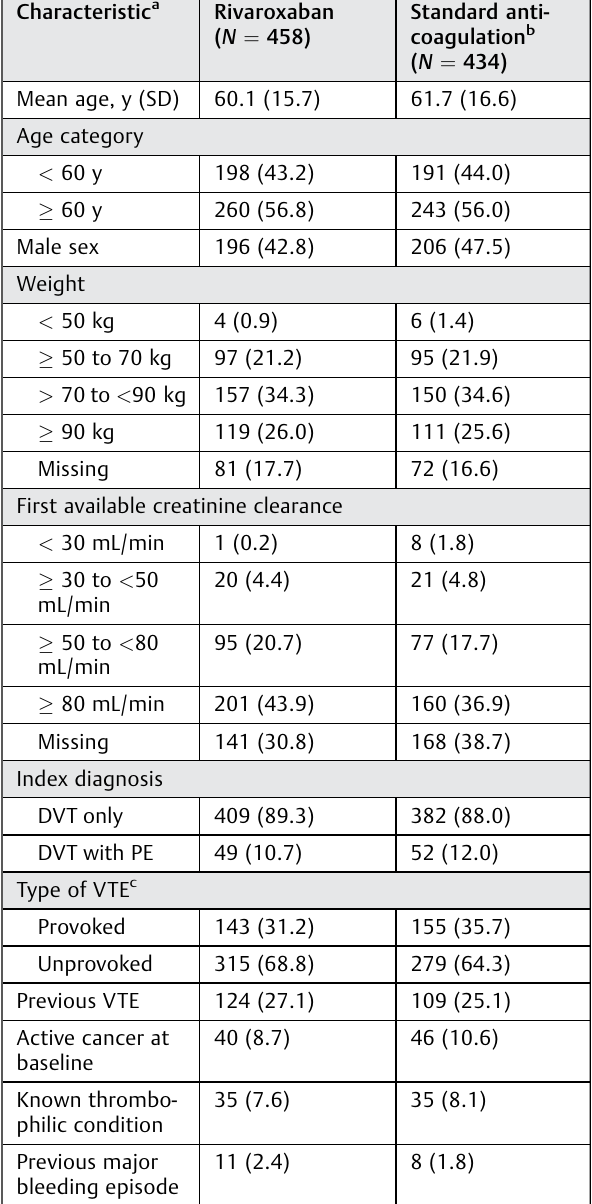
Table 1 Baseline demographics and clinical characteristics of patients in the XALIA treatment satisfaction substudy